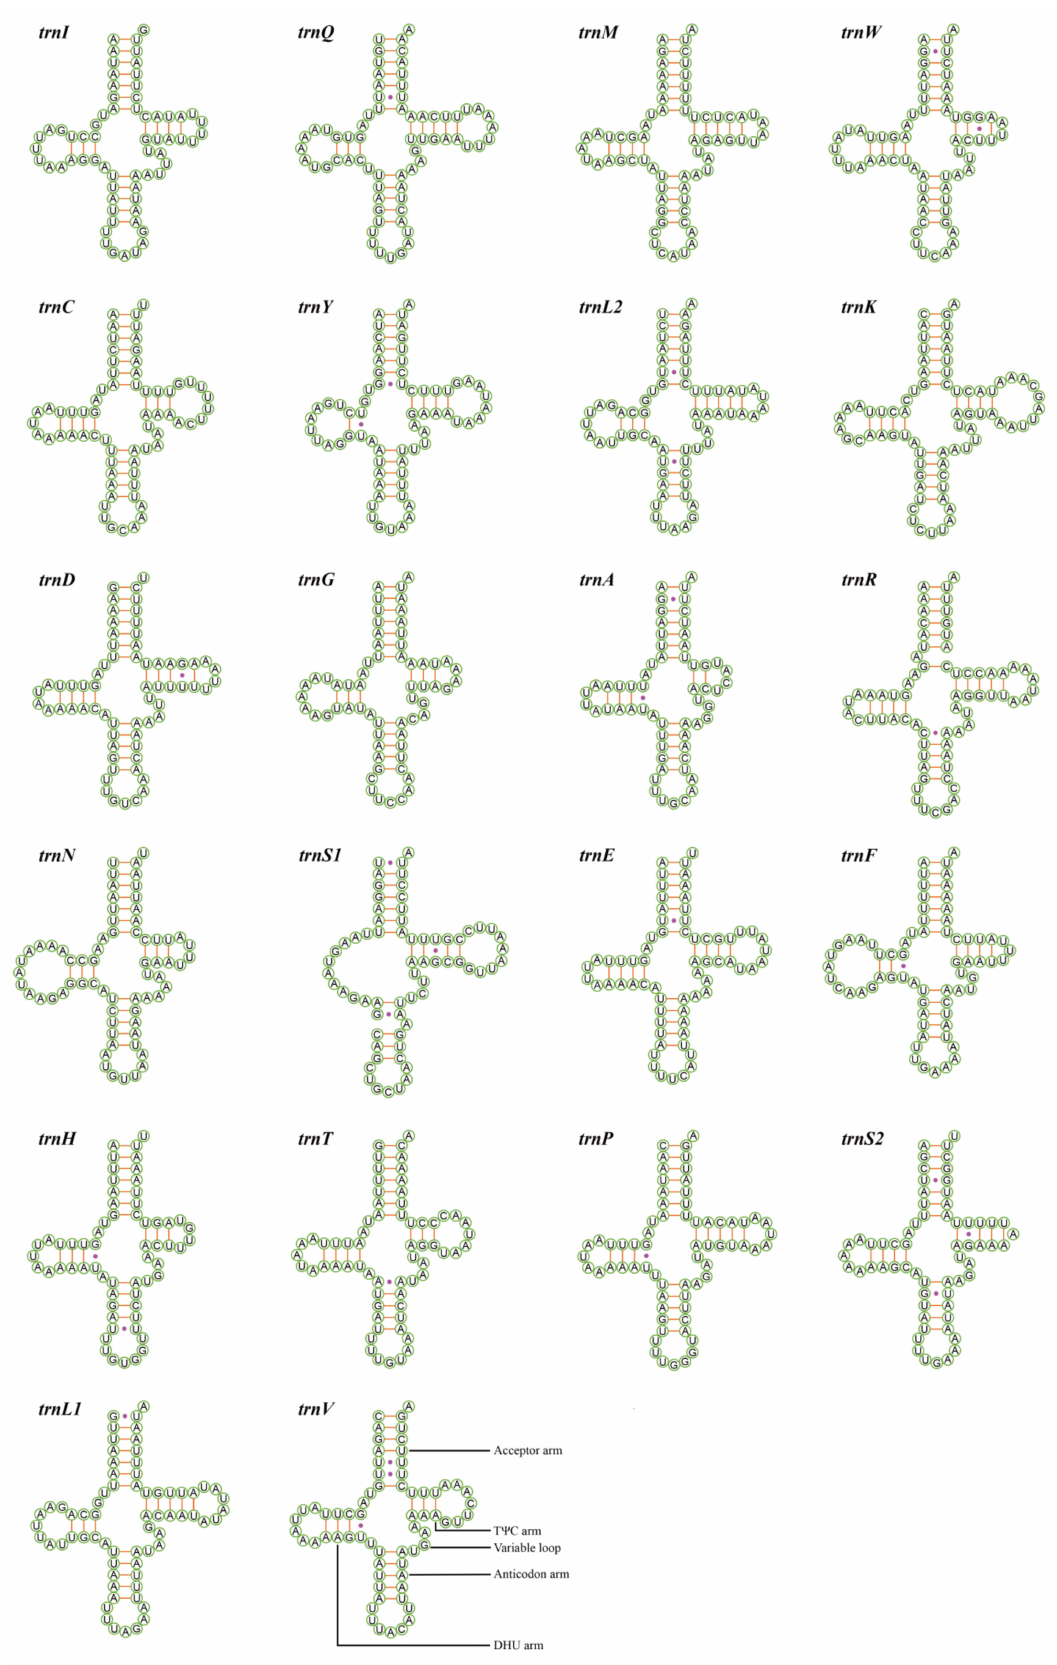
Figure 4. Putative secondary structure for the 22 tRNAs of Mileewa rufivena